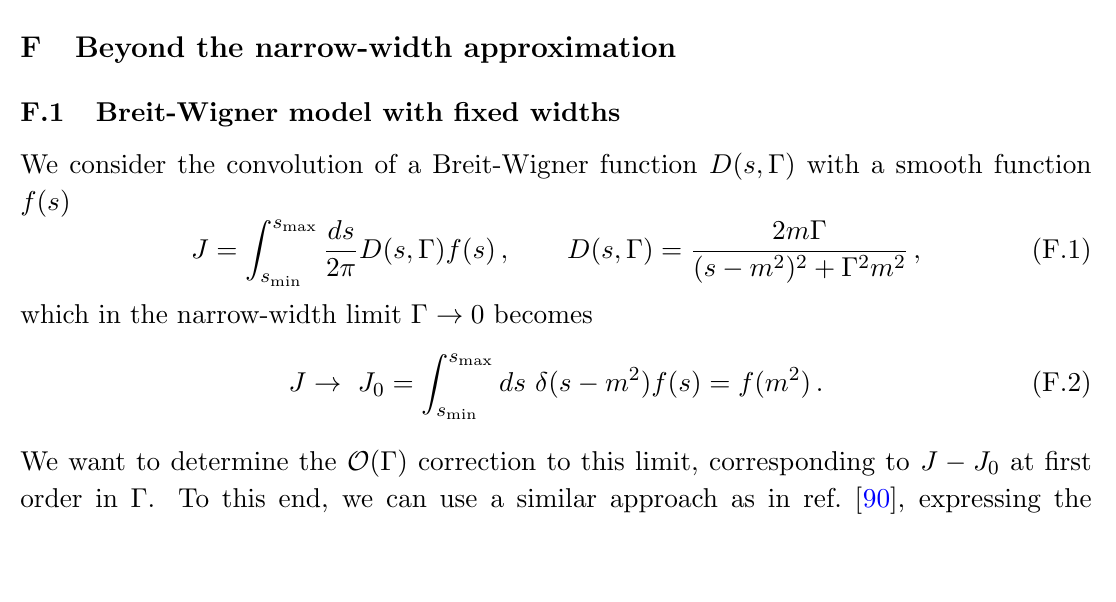
Table 10 . Results for the OPE coe(cid:14)cients in the z -expansion of tensor form factors in the three di(cid:11)erent models considered for B -meson LCDAs. When using this correlation matrix one must take into account the degeneracies that exist among several of the form factor